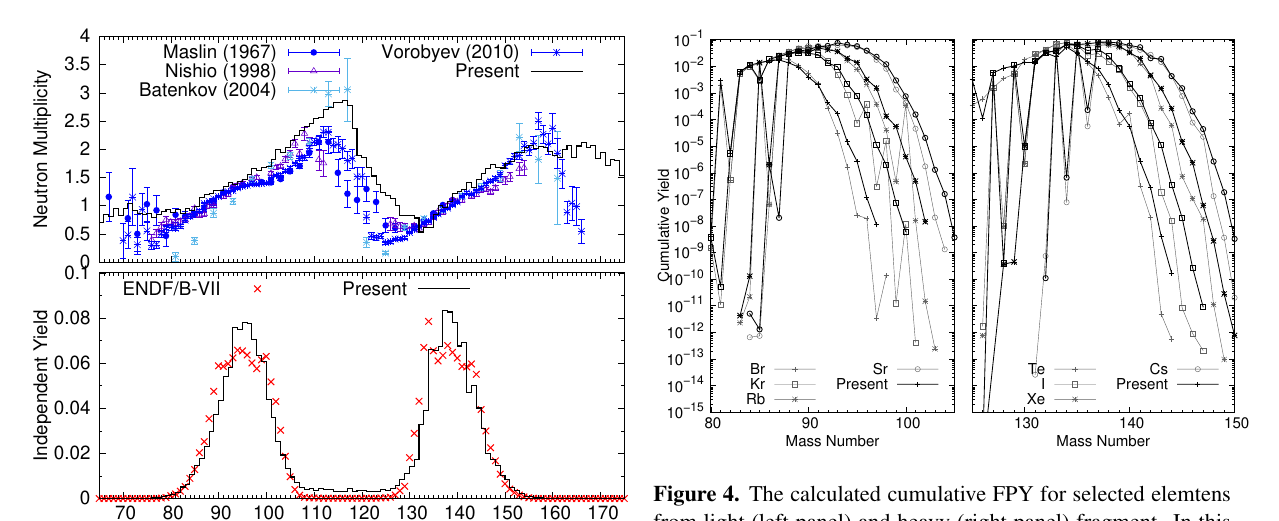
Figure 4. The calculated cumulative FPY for selected elemtens from light (left panel) and heavy (right panel) fragment. In this figure, only ground state yields are shown (metastable states are